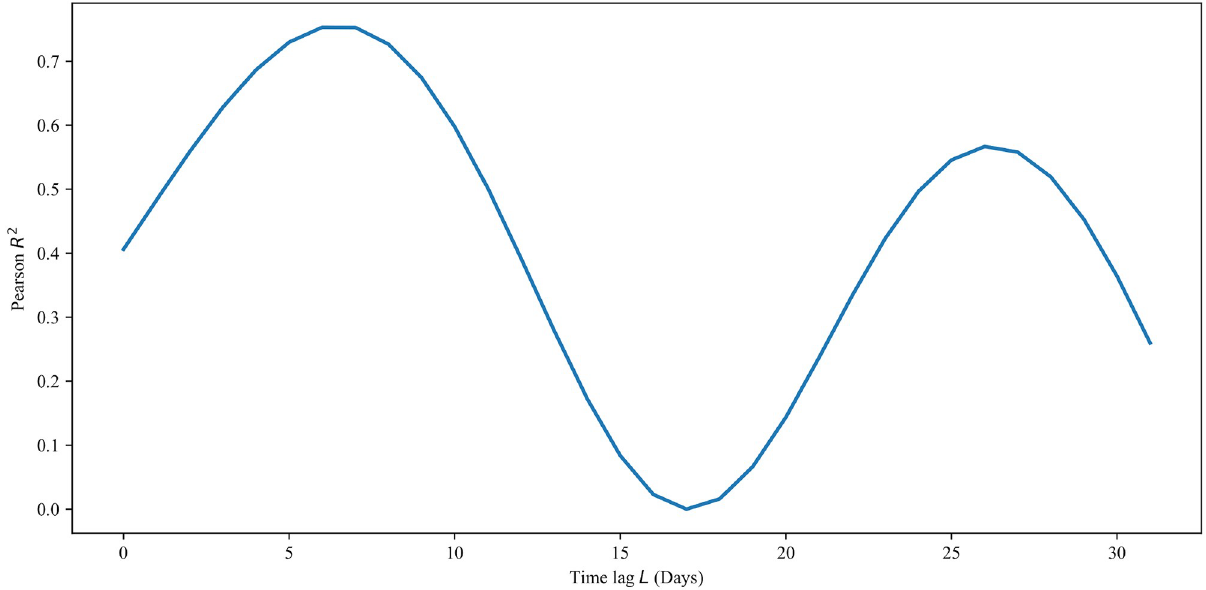
Fig 7. Pearson R 2 between public-response and time-lagged infections as a function of time lag. The square of the Pearson correlation coefficient, R 2 , between θ ( t ) and I ( t − L ) for t � t n , depicted respectively in Figs 2 and 3, for several values of the time lag L